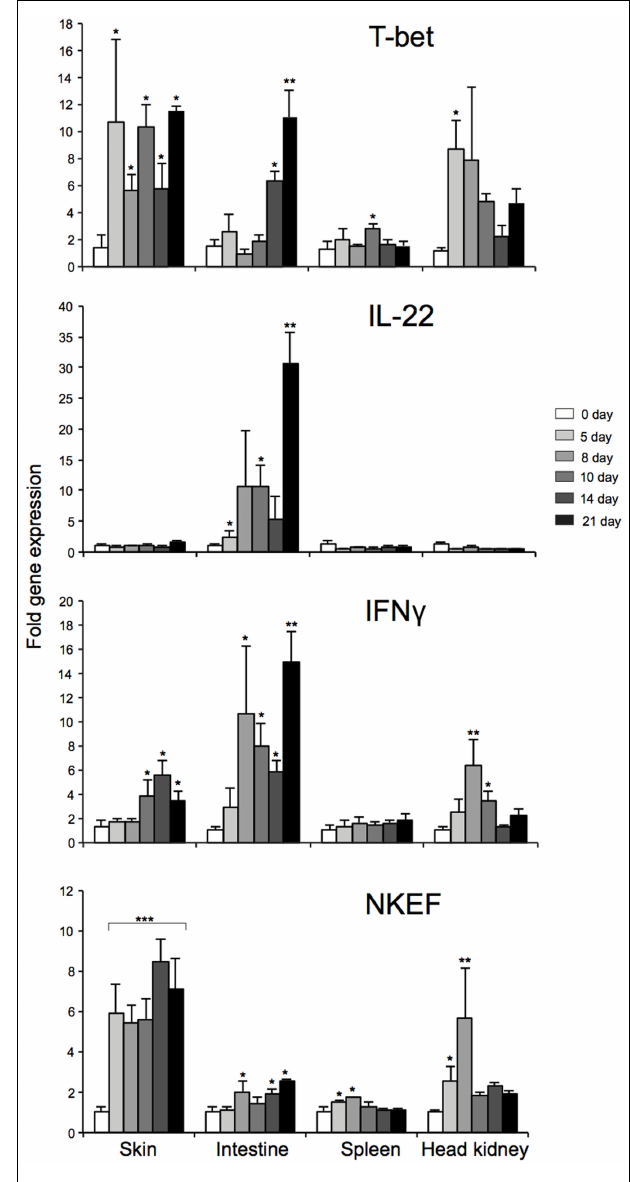
in infected Atlantic salmon at different time-points after water-borne infection with A. salmonicida . Bars represent the relative expression levels of T-bet, IL-22, NKEF, and IFN γ normalized to EF-1 α . Each value represents the mean ± SEM ( n = 4). Statistical differences ( P < 0.05, P < 0.01, and P < 0.001) between different time-points compared to control are indicated by asterisk (*,**, and ***) respectively, above the